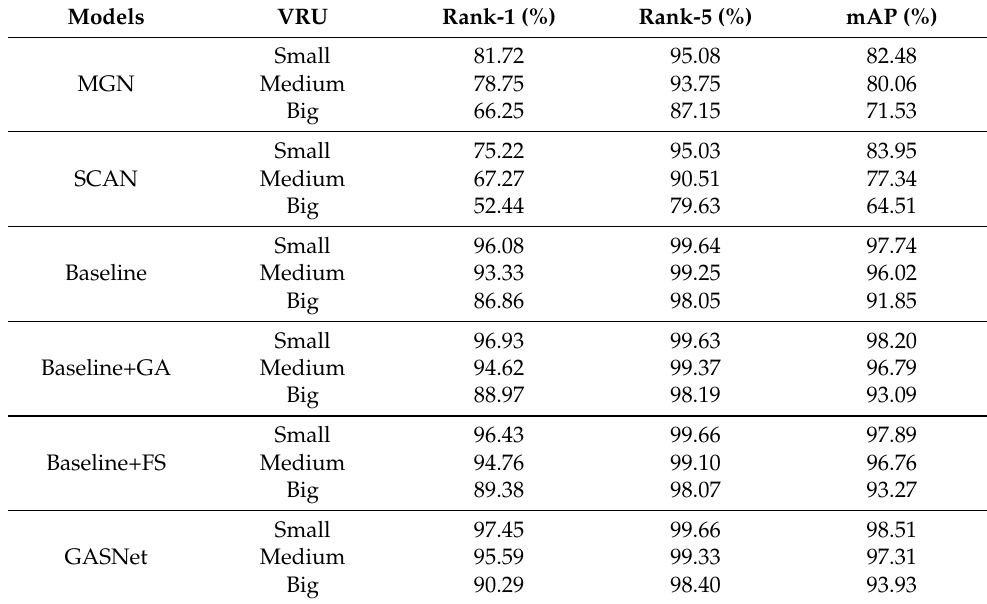
Table 2. The performance comparison with other ReID